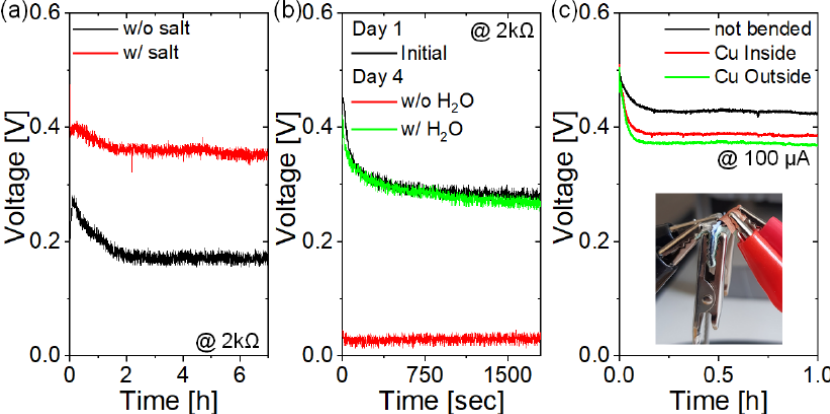
Figure 2. ( a ) Discharge Curve of textile-based battery with (red line) and without additional salt (black line) in the gel electrolyte at 2 k Ω resistance. ( b ) Discharge Curve of textile-based battery on the first day (black line) and fourth day (red line) after fabrication at a load of 2 k Ω . The battery shows, after four days, poor performance; therefore, two drops of water were soaked into the textile separator to improve the performance (green line). ( c ) Discharge curves of non-bended battery (black line) and 180° bended battery with copper as inner (red line) and outer (green line) electrode at 100 µA, with a picture of the bended textile-based